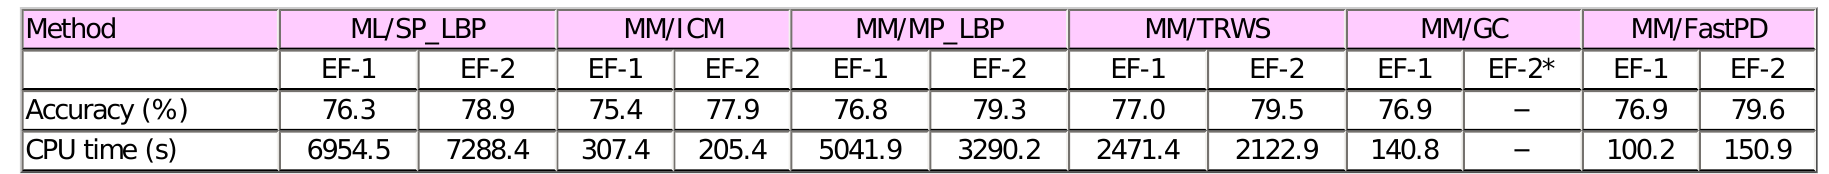
Table 7 Patch-level performances of CRF learning by the likelihood maximization (ML) and